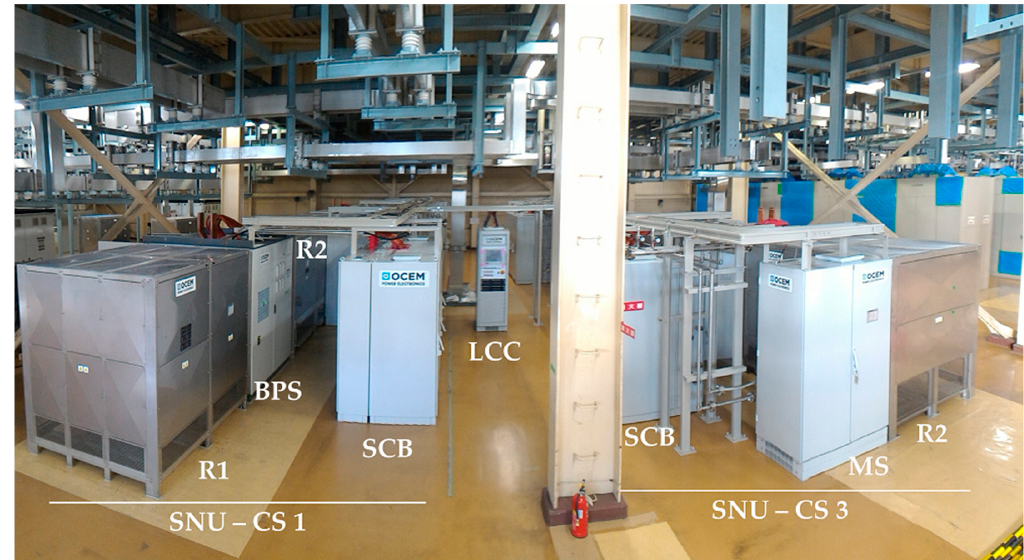
Figure 5. Panoramic picture of the four CS SNUs with their LCC (resulting in 21 cubicles) installed in the JT-60SA Rectifier Room in Naka. The cubicles belonging to the CS1 and CS3 SNUs are visible in foreground. Some of these cubicles are stressed in the picture. The common LCC is the small cubicle placed in the middle of the SNU area to manage the four SNUs at the same time.